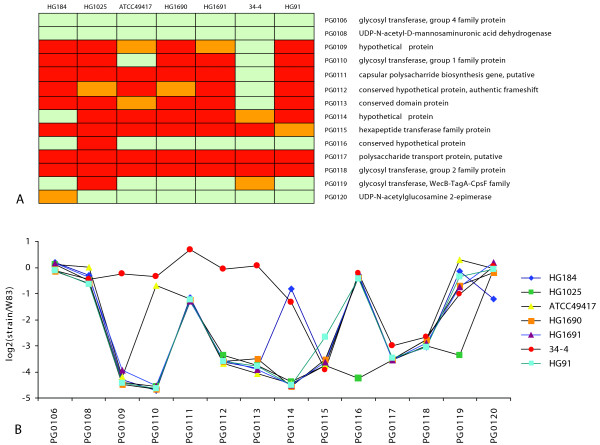
CPS biosynthesis locus diversity. A. Heat map showing presence (green), aberrance (orange) and absence (red) of each gene in each test strain, showing the variation within the CPS biosynthesis locus. The CPS locus of the serotype K7 strain 34-4 shows the highest similarity with the K1 serotype strain W83. B. For each probe in the CPS biosynthesis locus and for each test strain a log-ratio value compared to strain W83 is depicted by a data point, supporting the heat map results as shown in figure 4A.